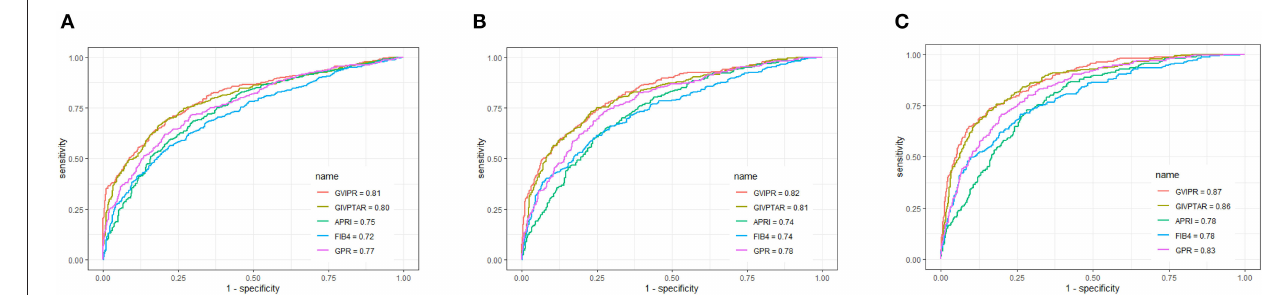
FIGURE 3 | Area under receiver operating characteristic (ROC) comparison of GIVPR, GIVPTAR, APRI, FIB-4, and GPR in training set. (A) ROC comparison for predicting significant fibrosis; (B) ROC comparison for predicting advanced fibrosis; (C) ROC comparison for predicting cirrhosis.